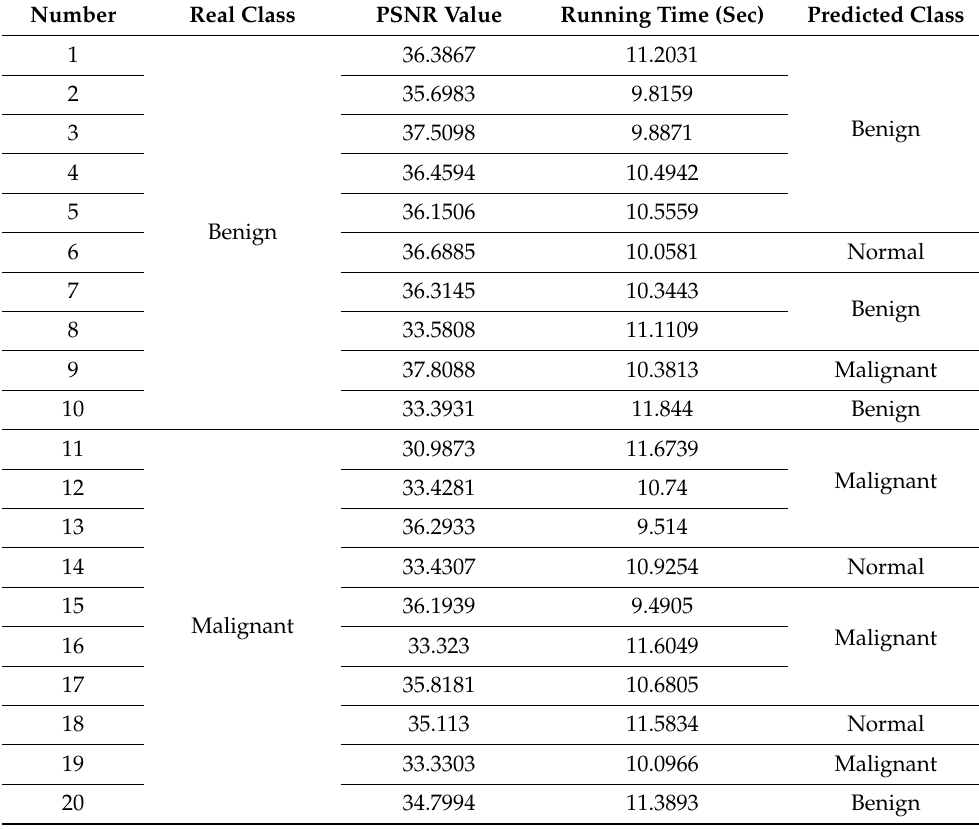
Figure 11. Validation loss. Table 4. Predicted Results with PSNR